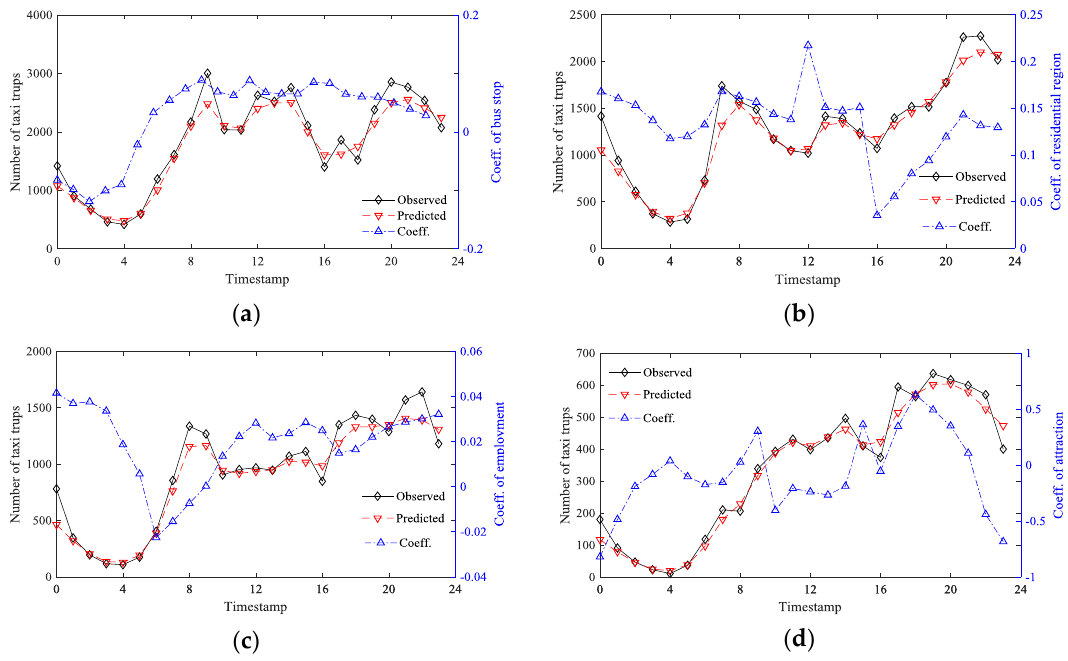
Figure 13. Temporal variation in taxi ridership and coefficients of explanatory variables at four selected regions based on the GTWR model. ( a ) Railway station; ( b ) high density of the residential buildings region; ( c ) high density of the region comprising places of employment; and ( d ) high density at attractions region.